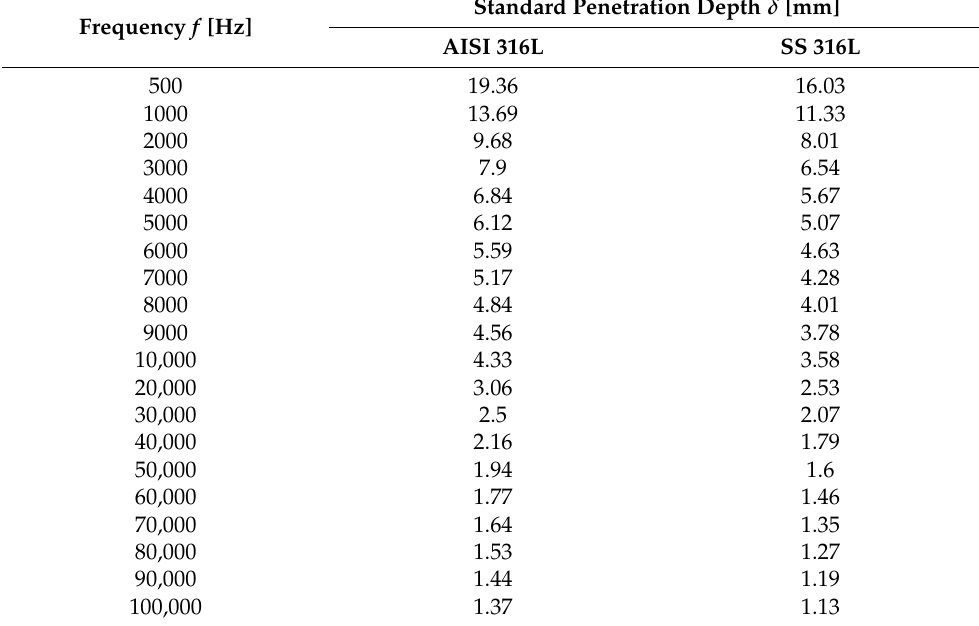
Table 2. Calculated standard penetration depth